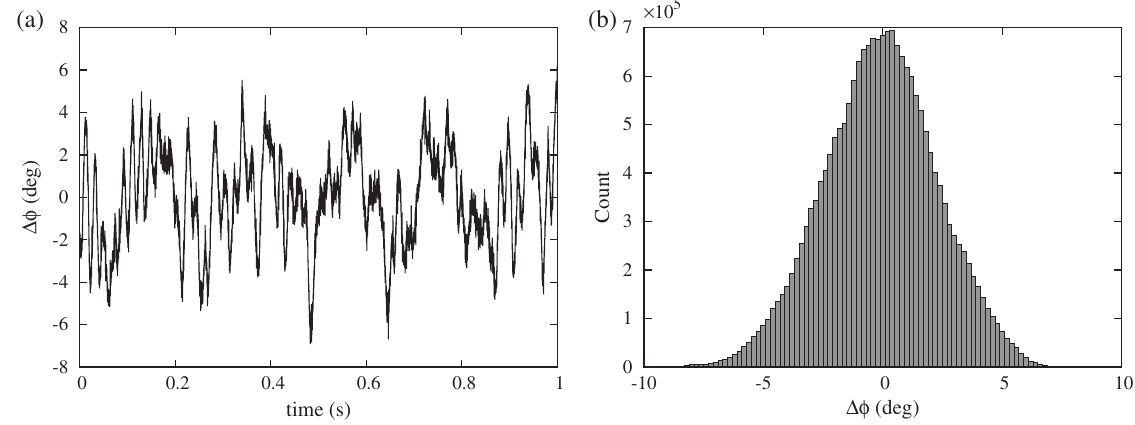
FIG. 6. Phase error of a freely oscillating superconducting cavity in SEL mode. Sinusoidal structures of several frequencies are superposed resulting in a nearly Gaussian distribution of the phase